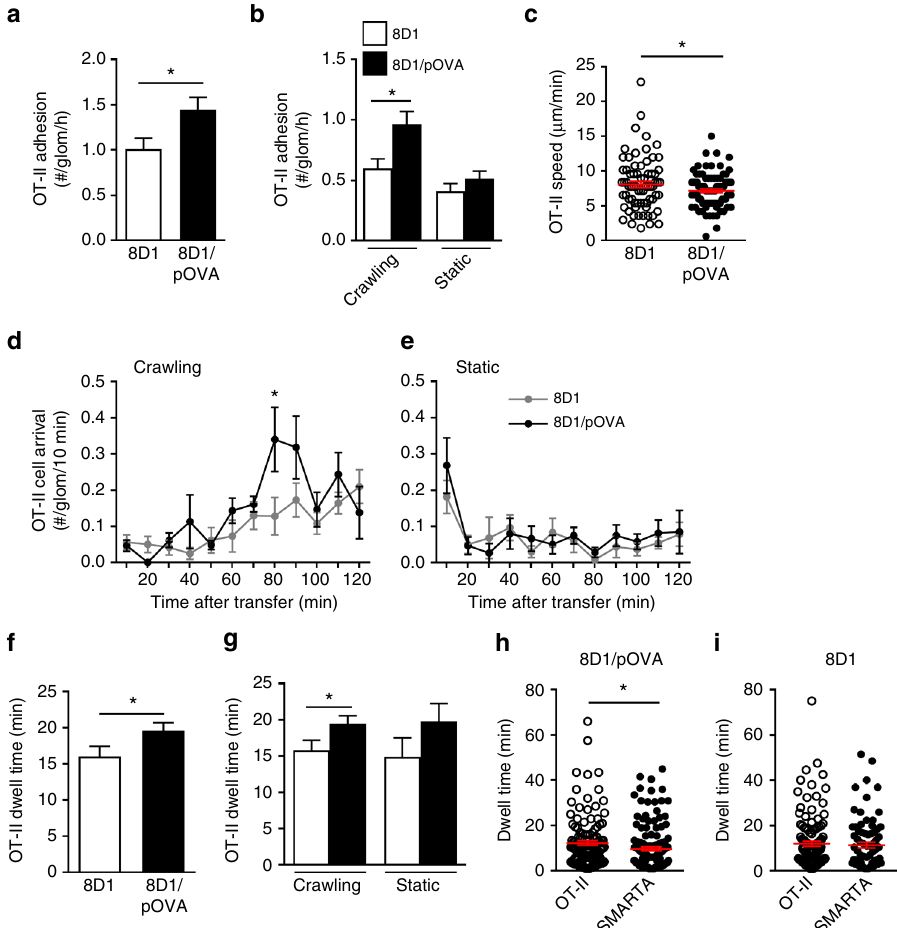
Fig. 2 Presence of antigen in glomeruli alters recruitment and migration of effector CD4 + T cells. Retention and migration of activated OT-II cells in glomerular capillaries were assessed via intravital multiphoton microscopy after i.v. administration of OT-II cells and either unconjugated control 8D1 mAb or 8D1/pOVA ( n = 6 mice per group). Data are shown for the total number of adherent OT-II cells ( a ), the number of crawling or static OT-II cells ( b ) and the crawling speed of OT-II cells ( c ) (8D1, n = 71 cells; 8D1/pOVA n = 83 cells). d , e Rate of arrival of adherent OT-II cells as assessed in 10-min intervals in the 2 h following administration, for crawling cells ( d ) and static cells ( e ). f , g Dwell time for OT-II cells, shown for total cells (8D1, n = 226; 8D1/pOVA, n = 423) ( f ), and for crawling (8D1, n = 132; 8D1/pOVA, n = 257) and static (8D1, n = 90; 8D1/pOVA, n = 148) cells ( g ). h , i Activated OT-II (pOVA- speci fi c) and SMARTA (LCMV-speci fi c) CD4 + T cells were co-transferred into mice treated with either 8D1-pOVA ( h ) or 8D1 ( i ), and glomerular retention of the two types of cells was assessed using multiphoton microscopy. Shown are individual T-cell dwell times 30 – 120 min after cell transfer, as well